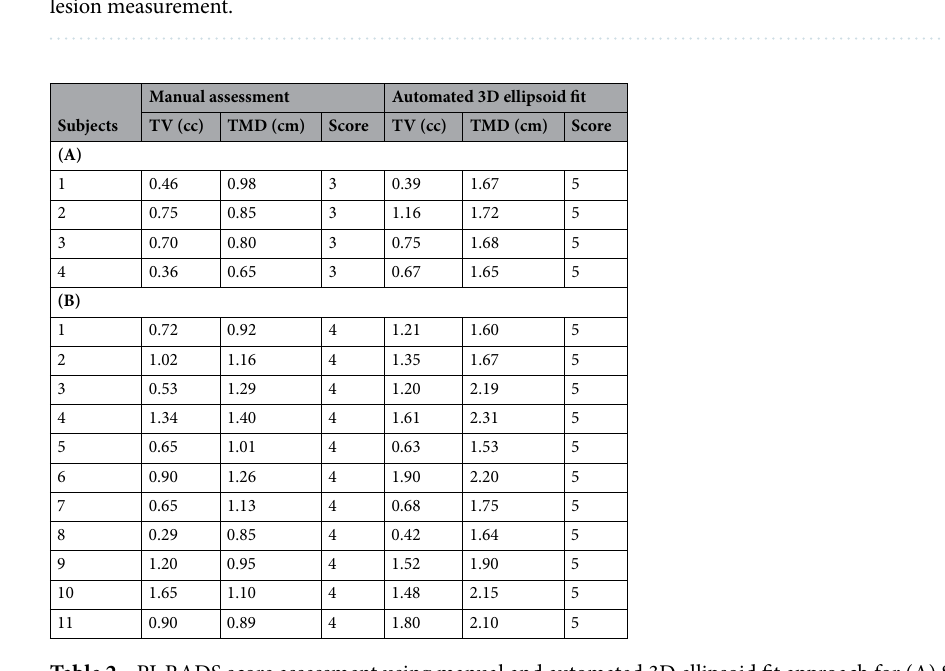
Figure 4. Lesion measurements of a representative patient (age = 60 years) using manual and ellipsoid-fit method. ( A ) Lesion ROIs, ( B ) Radiologist manual lesion measurement and ( C ) 3D ellipsoid-fit method based lesion measurement.